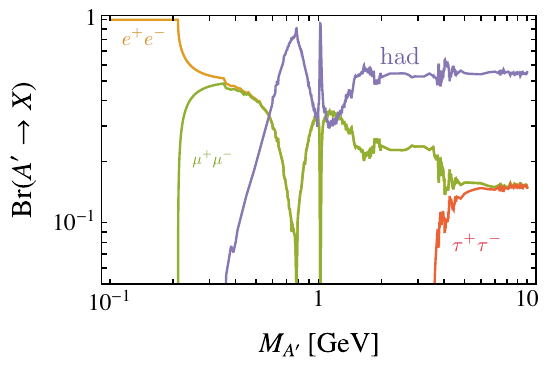
Figure 2 . Branching ratios for the gauge bosons of a secluded U(1) the SM hypercharge gauge boson. See text for